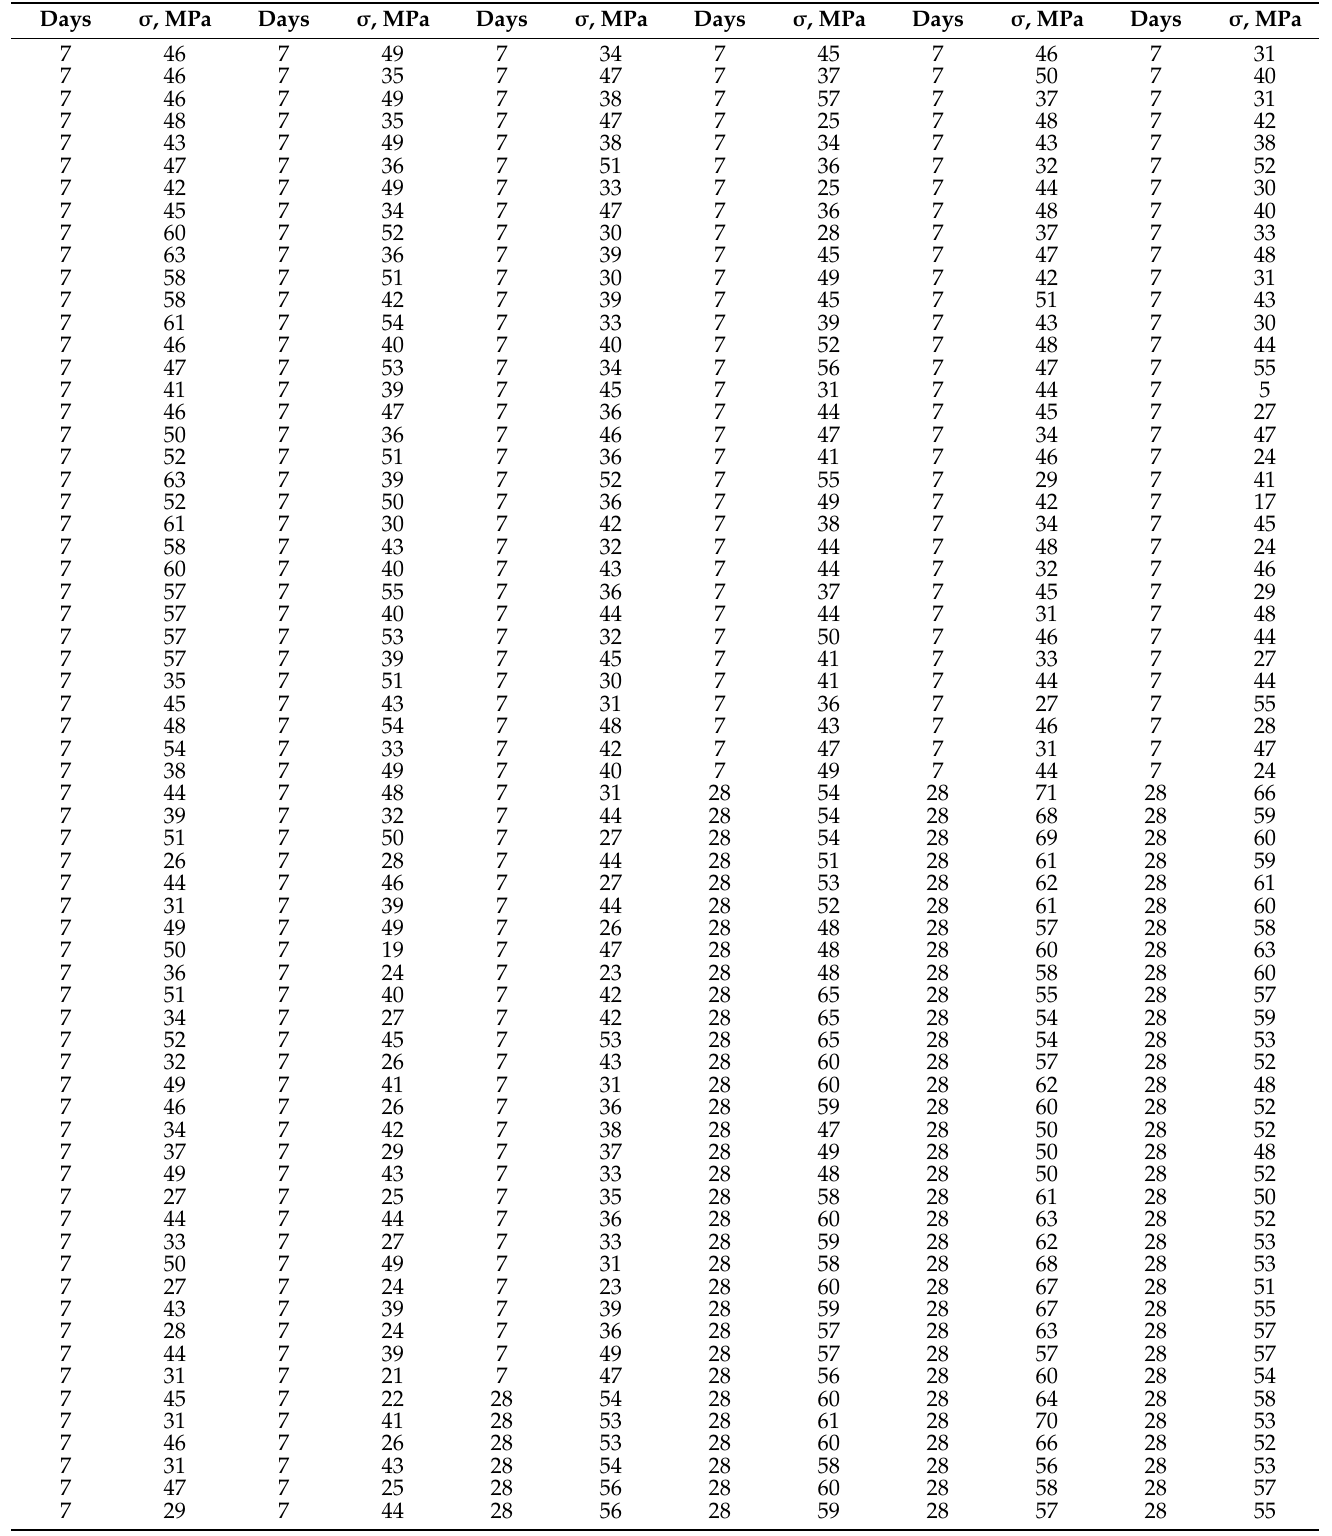
Table A2. Compressive strength of the concrete mixture f’ c = 38